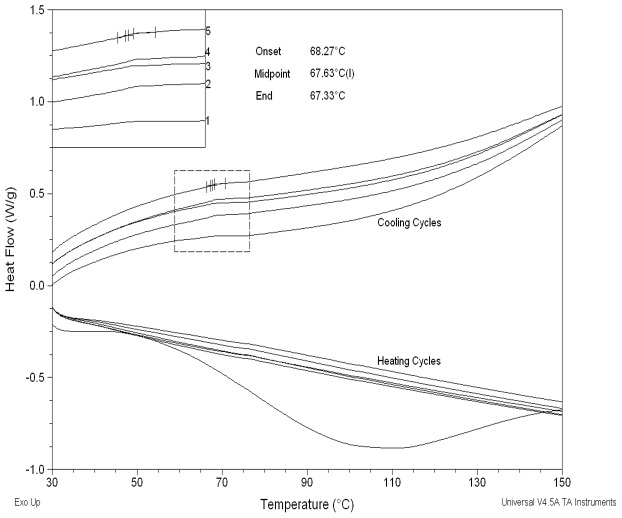
DSC thermogram of MCC showing consecutive heating and cooling runs obtained from cyclic mode analysis.The Tg of MCC at 67.63°C is seen in the cooling runs with increased clarity in the run order 1–5 as moisture (3.46±0.17%) was continuously evaporated.